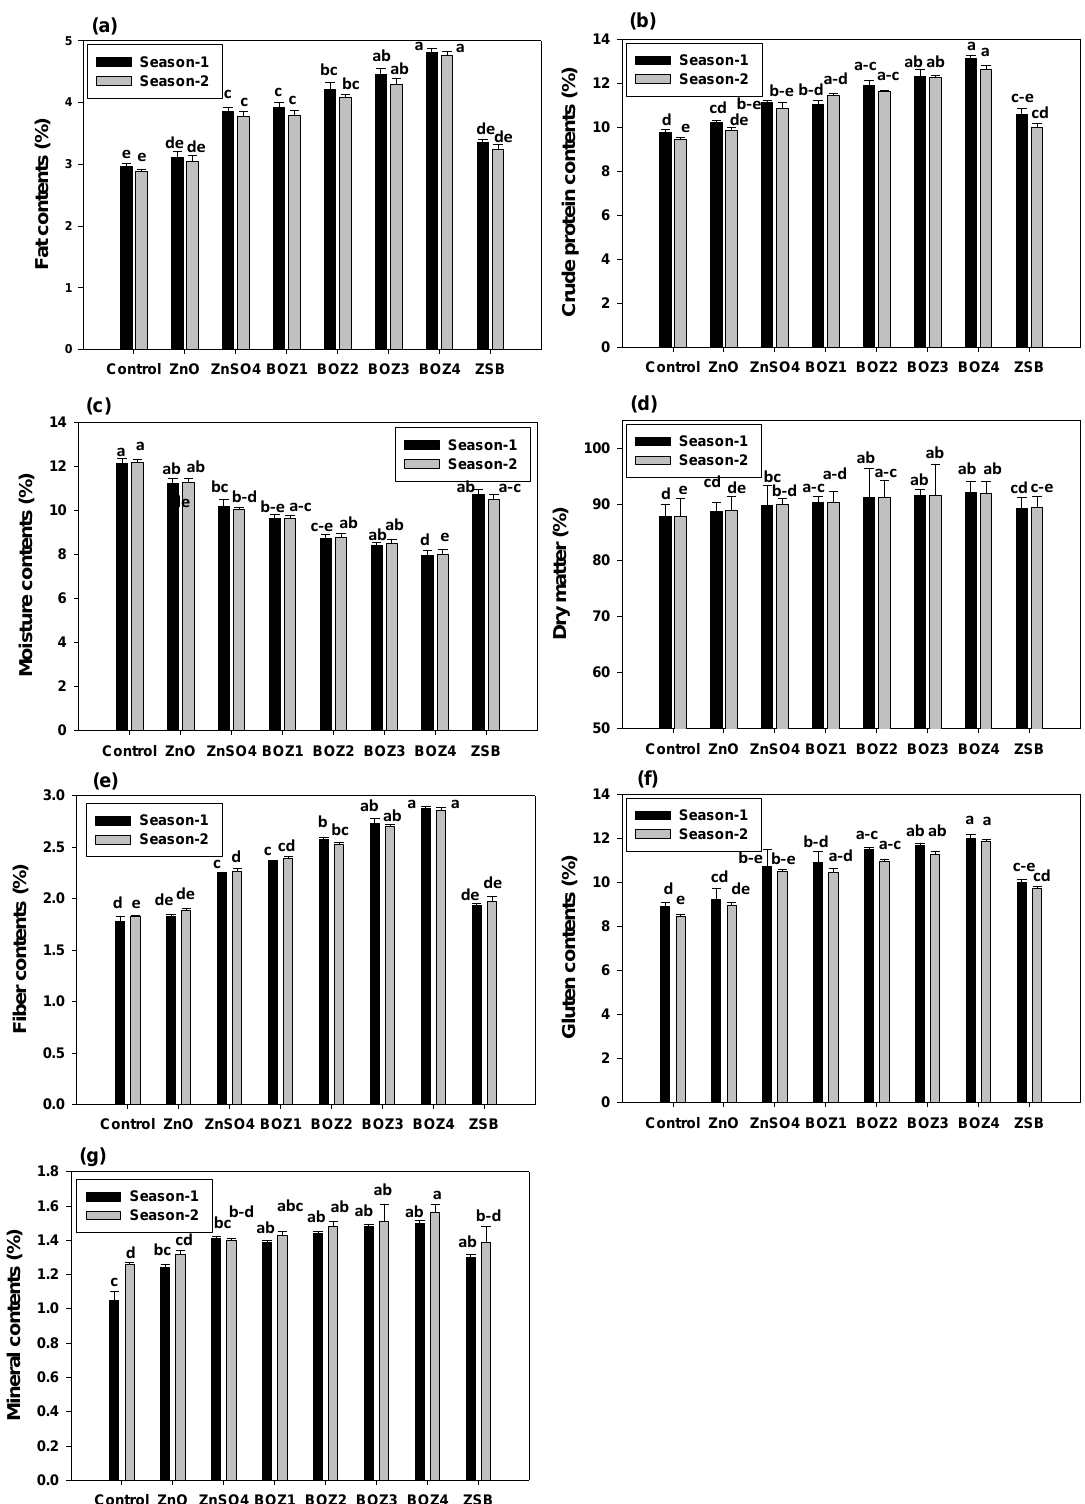
Figure 2. Effect of different Zn sources on gain fat contents ( a ), crude protein contents ( b ), moisture contents ( c ), dry matter ( d ), fiber contents ( e ), gluten contents ( f ), and mineral contents ( g ) of maize grown in two different cropping seasons (Data are shown as mean of three replications. Means followed by same letter(s) are not significantly different according to Tukey’s HSD (honestly significant difference) test at p ≤ 0.05).